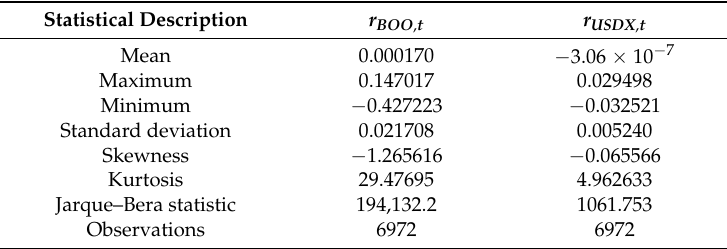
Table 1. Statistical description of variables.